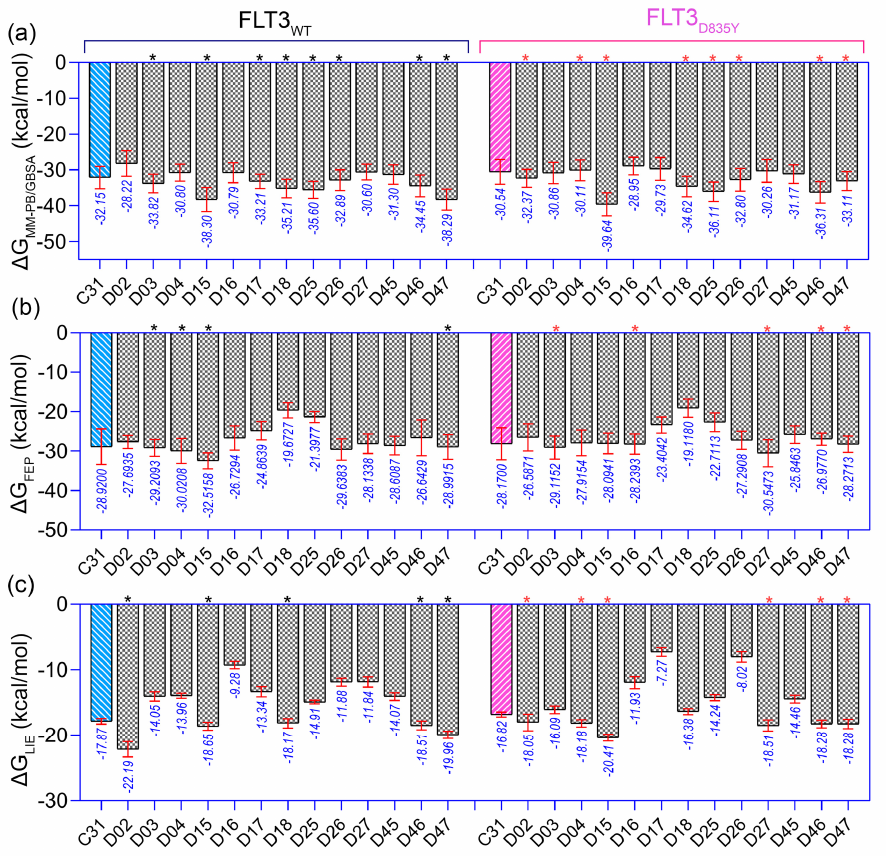
Figure 6. Comparison of the binding free energy of the designed compounds. ( a ) ∆ G MM − PB/GBSA , ( b ) ∆ G LIE , and ( c ) ∆ G FEP binding free energy to wild-type (FLT3) and mutant (FLT3 D835Y ) receptors. The higher estimated binding free energies of the designed compounds than the most active com- pound C31 are marked by the black (for wild-type FLT3) and pink asterisk (for FLT3 D835Y ). The energy values shown below the standard deviation bar in blue are in